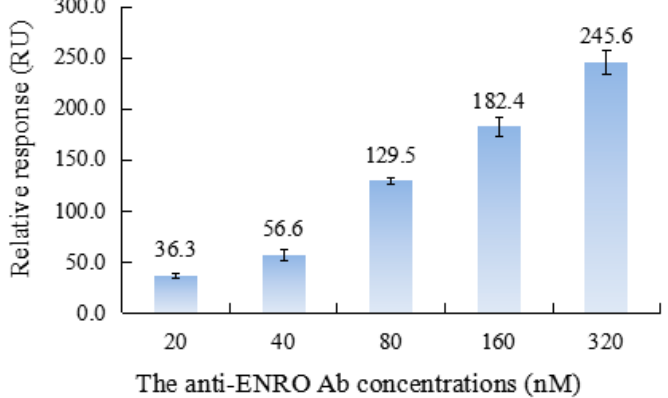
Figure 5. SPR response from the binding of the ligands with anti-ENRO Ab at different